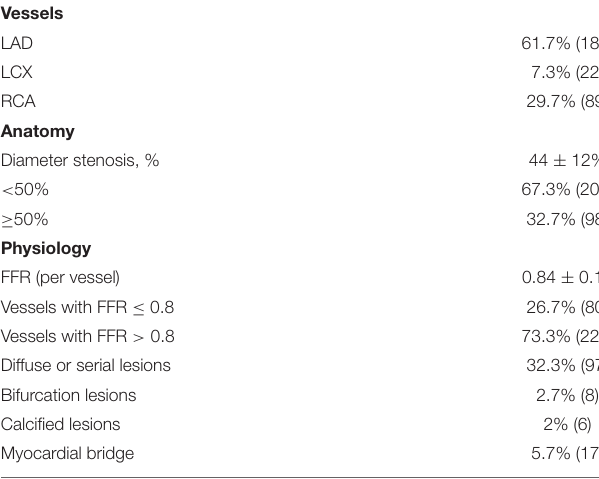
TABLE 2 | Vessel characteristics ( n =